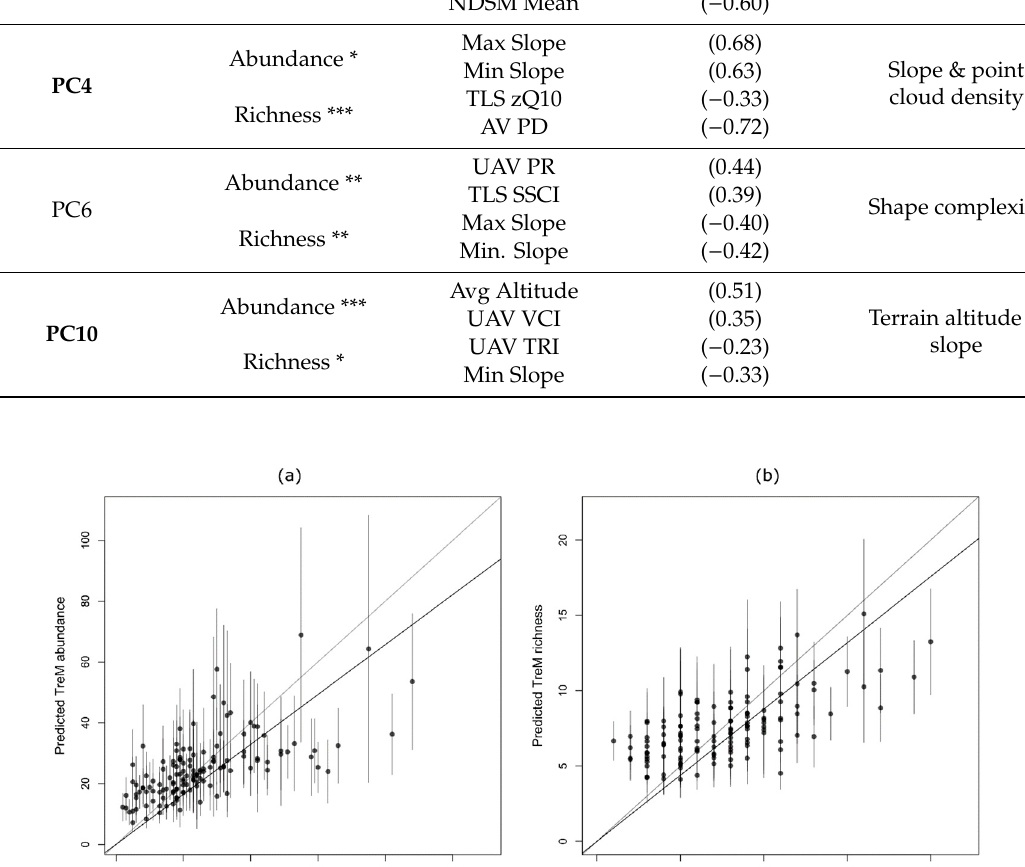
Figure 5. Results of the cross validation. Straight lines indicate the mean RMSE of the training data and dotted lines of the test data as cumulative mean up to the specific test (all RMSEs averaged until n -test). The left panel shows the results for TreM abundance, the right panel for TreM richness. The model that contained only data collected by UAV performed a little better for the TreM abundance prediction (+6% deviance explained), while the model that contained data collected by